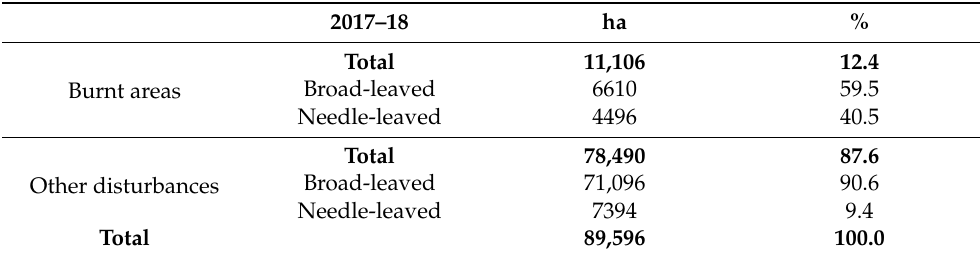
Table 10. Distribution of forest disturbances occurring between 2017 and 2018 among woody vegetation